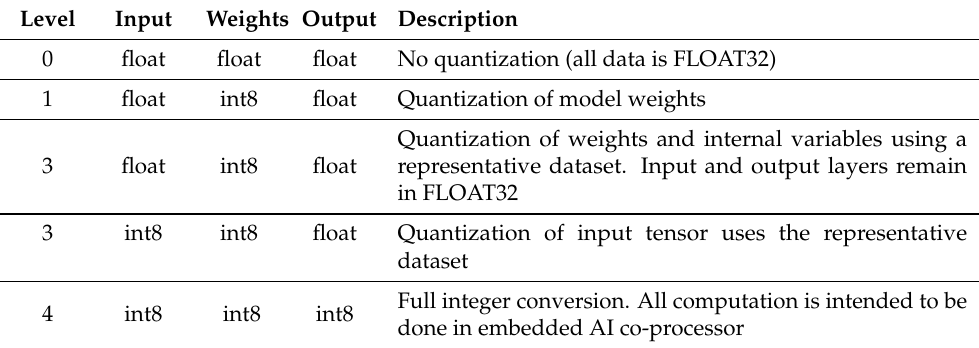
Table 1. Model quantization (optimization) levels used in this